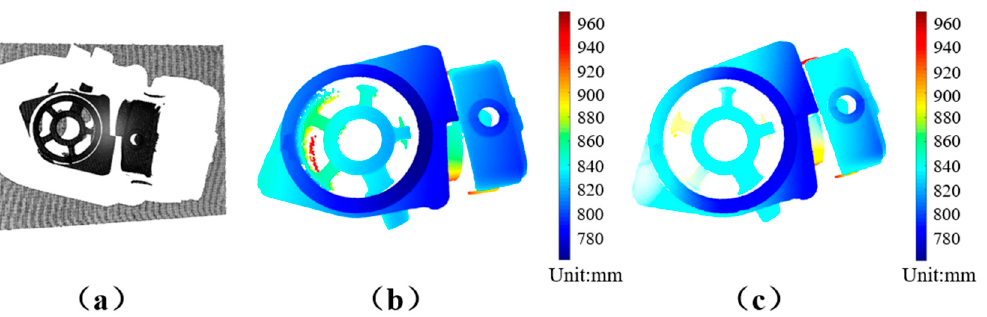
Figure 6. Results of different point cloud pretreatment methods. ( a ) Rendering of voxel grid filtering. ( b ) Straight through filtering effect diagram. ( c ) Effect diagram of statistical filtering.